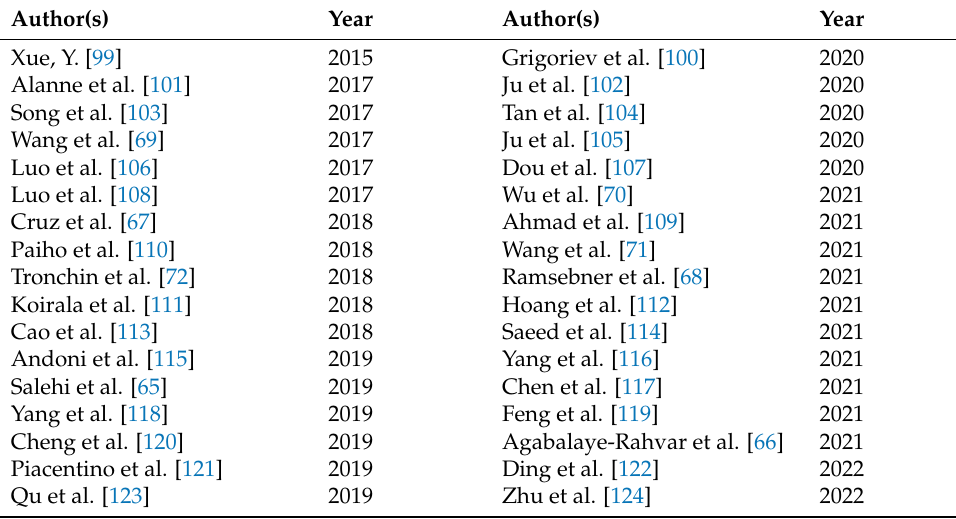
Table A1. “More relevant” articles regarding the integration of IoT and